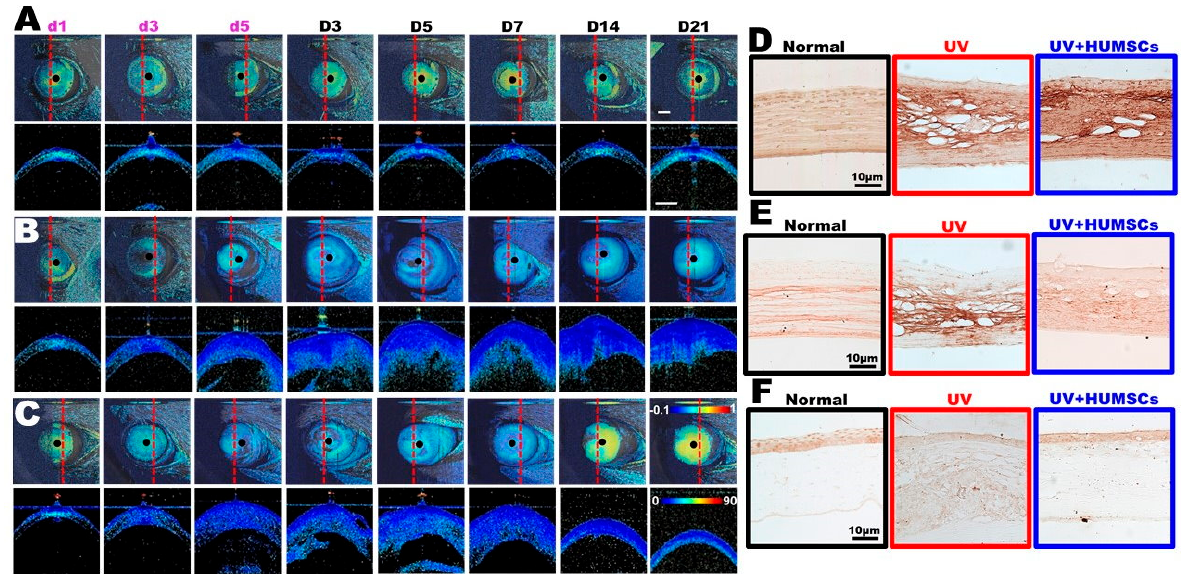
Figure 4. HUMSCs transplantation enhances the corneal collagen organization after UV irradiation. Multifunction OCT showing the birefringence map (upper row), in which dashed lines illustrate representative 2D phase retardation images (lower row) in the Normal ( A ), UV ( B ), and UV + HUMSC ( C ) groups. Immunohistostaining shows the distribution of fibronectin ( D ), collagen I ( E ), and collagen III ( F ) expressions in the stromal layer of corneas in the Normal, UV, and UV + HUMSC groups. The results show the distribution and arrangement of the extracellular matrix in the UV + HUMSC group were similar to those in the Normal group.